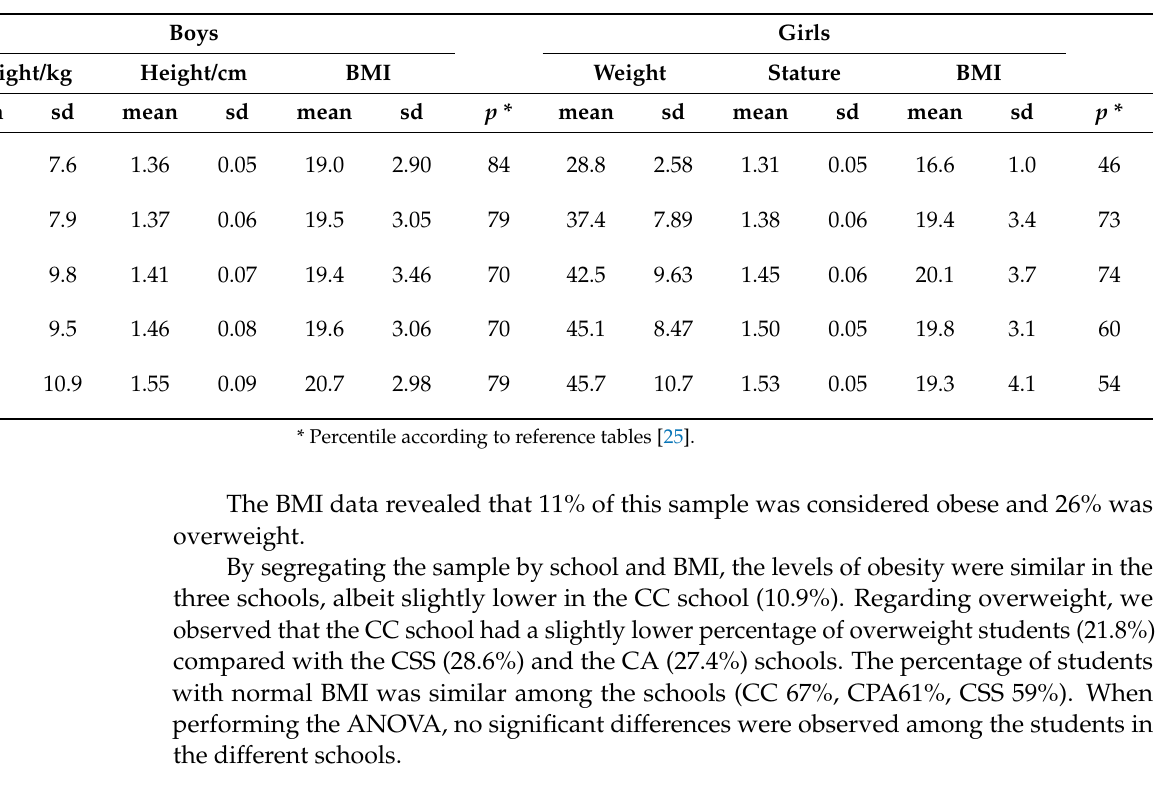
Table 3. Distribution of weight, size, and body mass index (BMI) statistics by gender and age.